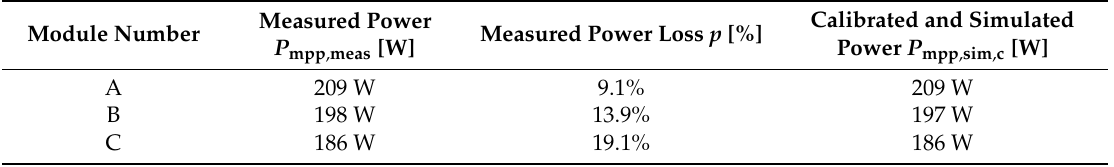
Table 1. Calibrated simulation results of three multicrystalline modules (A, B and C) from the same site with hail damage. The calibration module A was used to determine the ideality factor n id = 1.4 as the optimal simulation setup ( P mpp,meas ( A ) ≈ P mpp,sim,c ( A ) ). The calibration of the ideality factor